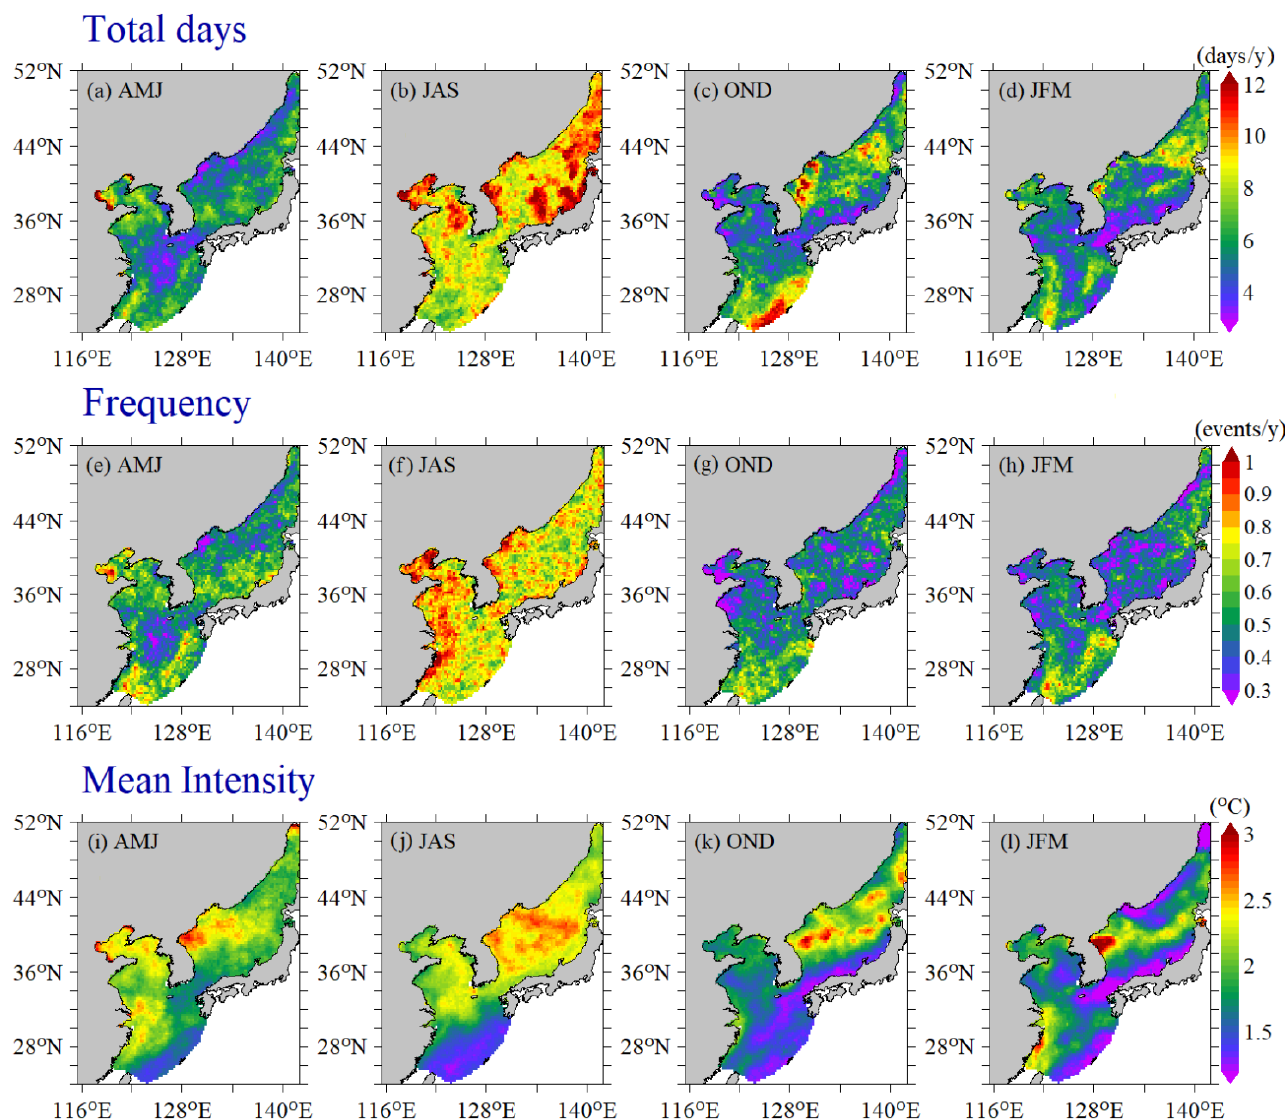
Figure 3. Spatial distribution of seasonal MHW characteristics for spring (April–June; AMJ), summer (July–September; JAS), fall (October–December; OND), and winter (January–March; JFM) from 1982 to 2020 in the EAMS. ( a – d ) Total days; ( e – h ) frequency; ( i – l ) mean intensity.